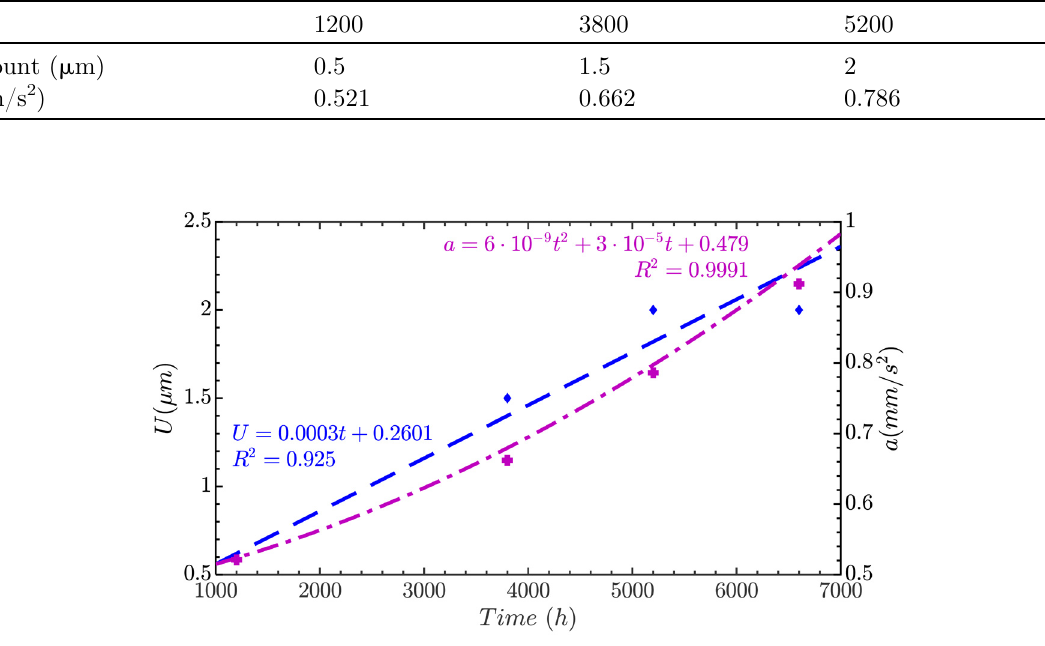
Fig. 6. Graphs and equations of wear amount and RMS with